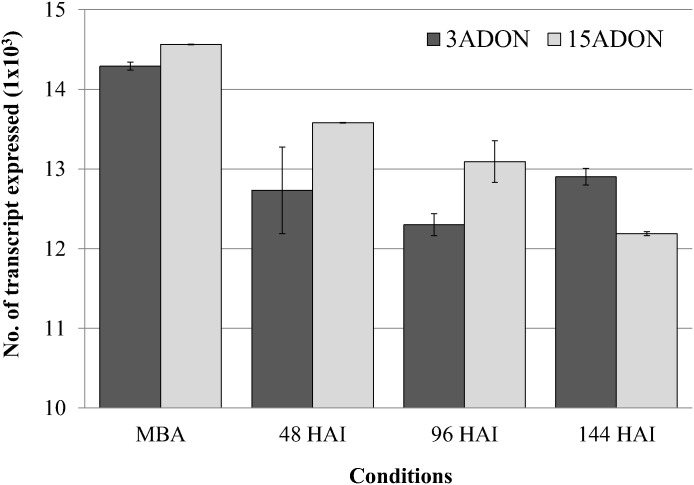
Total numbers of transcripts expressed by the 3ADON and 15ADON populations in vitro and in planta.Transcript-fragment reads from each sample were mapped to the reference genome (F. graminearum PH-1) using Bowtie version 0.12.5 [46] and TopHat version 2.0.0 [47]. Fragments per kilobase of transcript per million fragments mapped (FPKM) were calculated by Cufflinks version 0.9.3 [48]. HAI: hours after inoculation, 3ADON: the 3ADON population producing 3-acetyl-deoxynivalenol and DON, 15ADON: the 15ADON population producing 15-acetyl-deoxynivalenol and DON, vertical bar represents standard error of means between replications, MBA: mung bean agar (in vitro).